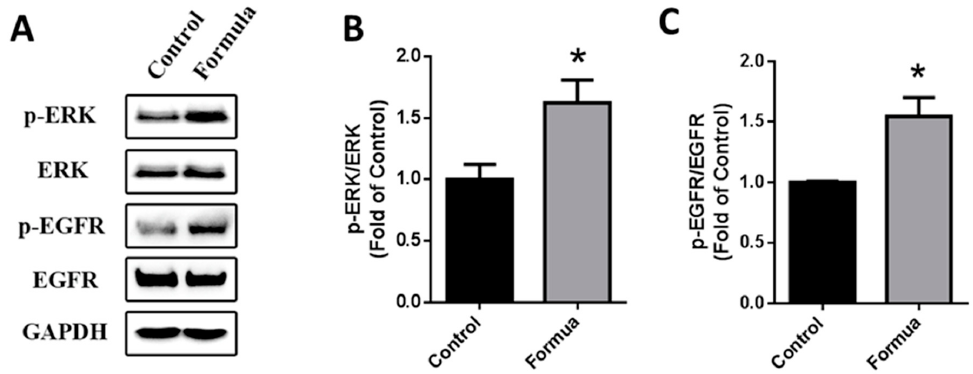
Figure 6. WPF-induced activation of EGFR-ERK pathway. Human gastric epithelial cell line (GES-1) cells were treated with control (PBS) or WPF (1.3 mg/mL) for 12 h before protein was extracted by cell lysis buffer and analyzed using Western blot. GAPDH was used as a loading control. ( A ) Representative blots of p-ERK, ERK, p-EGFR and EGFR; ( B ) Changes of p-ERK/ERK; ( C ) Changes of p-EGFR/EGFR. Data are presented as mean ± SD. * p < 0.05 vs. control. Experiments repeated at least three